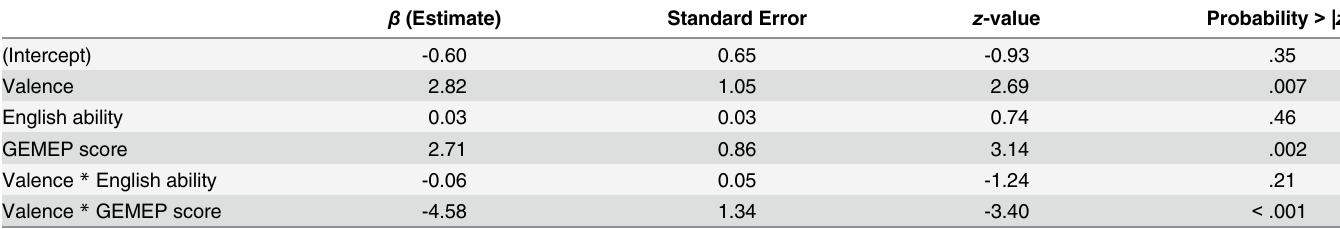
Table 5. Results from affect burst